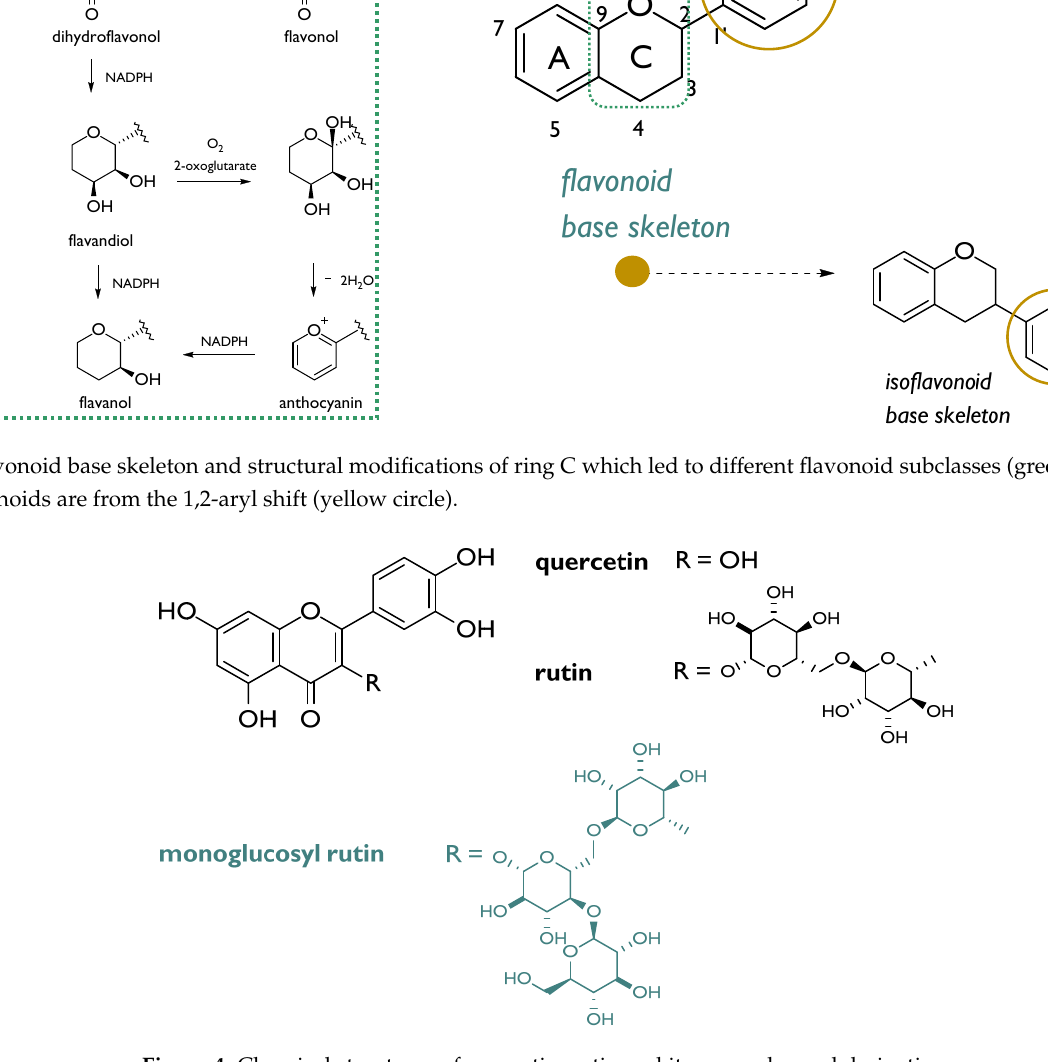
Figure 4. Chemical structures of quercetin, rutin and its monoglucosyl derivative .